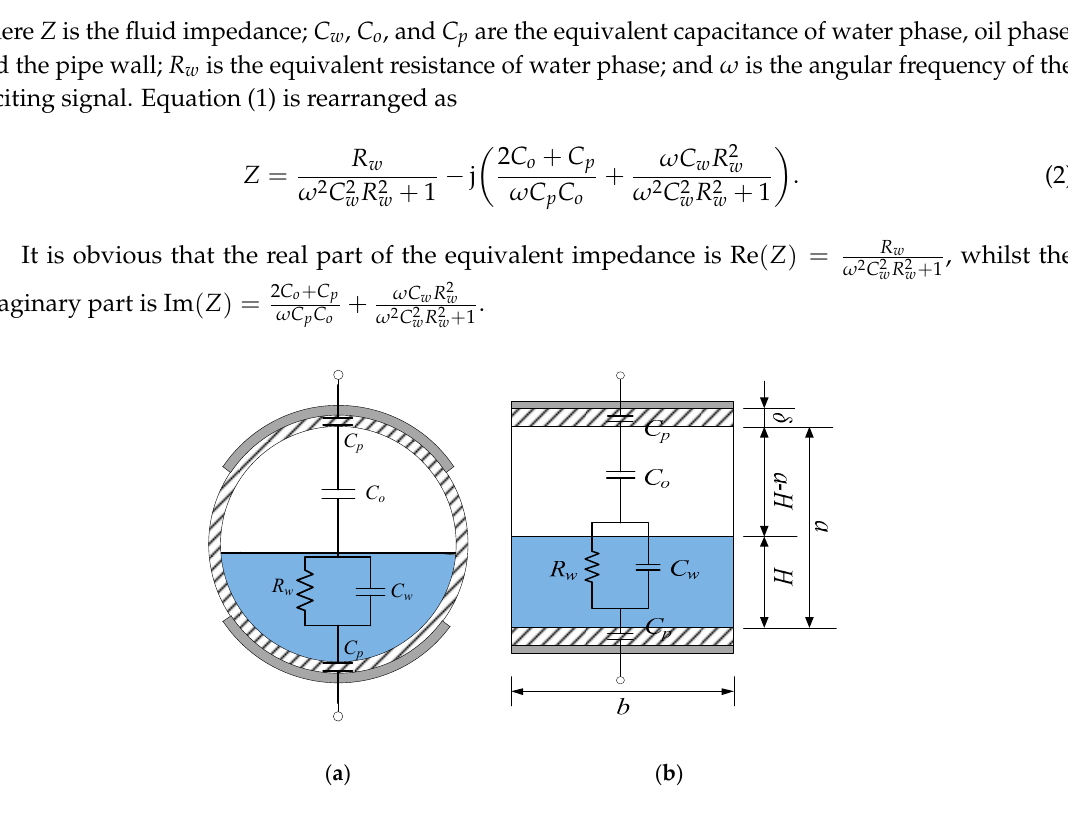
Figure 2. Impedance structure analysis of the concave capacitance sensor (CCS) for the stratified flow (ST) flow pattern: ( a ) equivalent impedance circuit model; ( b ) simplified impedance circuit model.